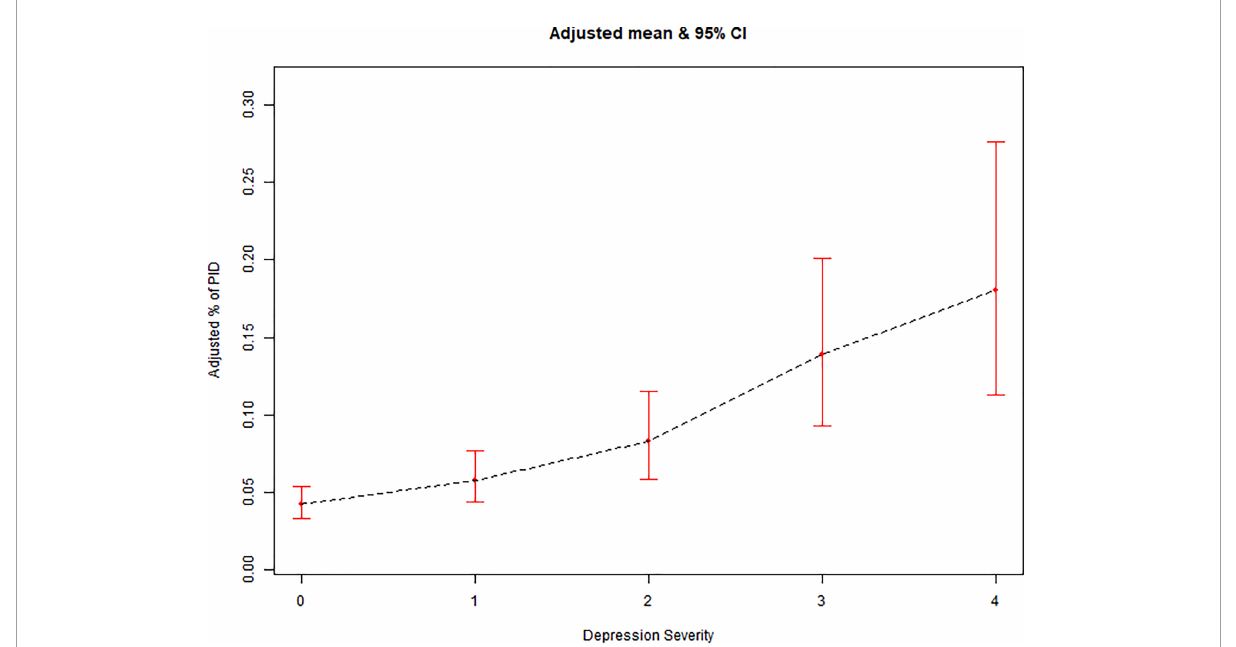
FIGURE3 Prevalence of pelvic inflammatory diseases (PID) vs. depression severity: association PID and depression severity: A linear association between PID and Depression Severity was found in a generalized additive model (GAM). 0 = Non, 1 = Mild, 2 = Moderate, 3 = Moderately Severe, 4 =